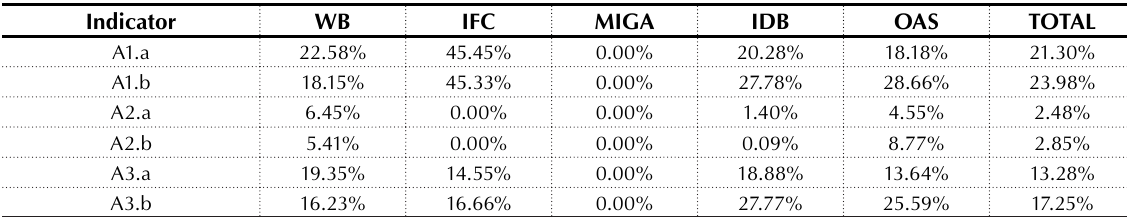
Table 8. Indicators of the level of financial inclusion in the development objectives of the projects,